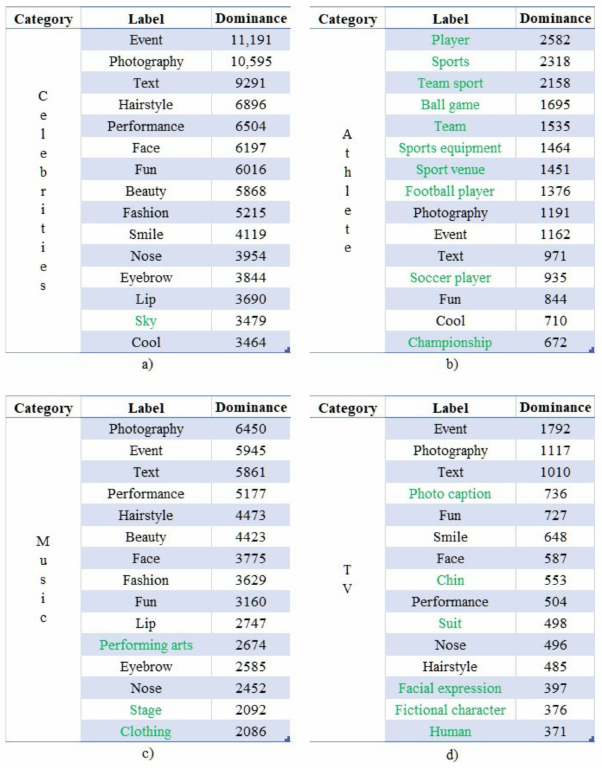
Figure 7. The top 15 dominant labels ( a – d ) per community of